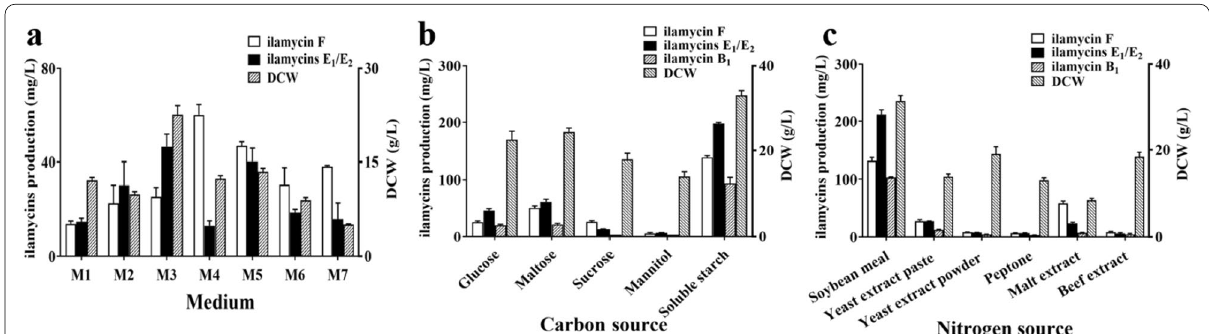
Fig. 2 Ilamycins production and DCW in M1-M7 ( a ) and effect of different carbon ( b ) and nitrogen ( c ) sources on DCW and ilamycins